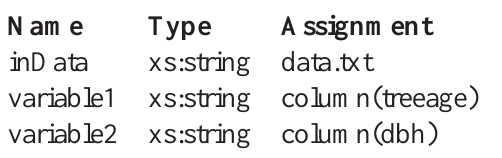
Table 3: Example of a parameter assignment for a data